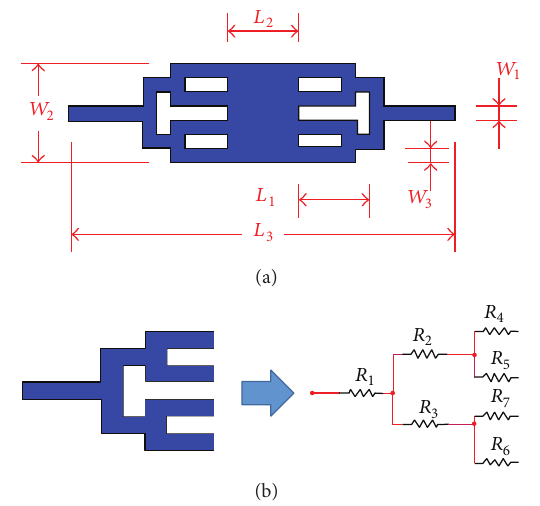
Figure 2: Schematic design of (a) tree-like flow division microflu- idic channel with its (b) equivalent electric circuit